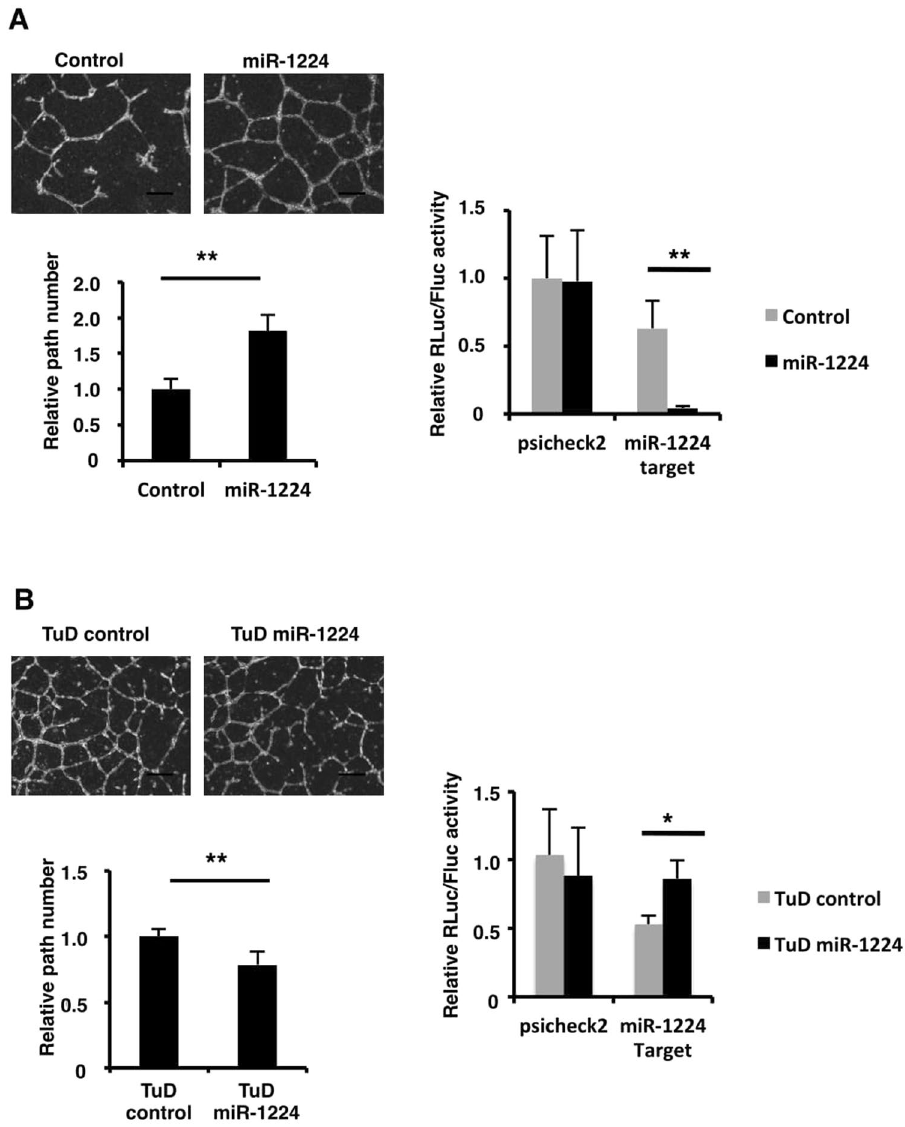
Figure 2. miR-1224 stimulated, and its inhibitor repressed, tube formation of HUVECs. ( A ) Tube formation assay of HUVECs transfected with miR-1224 mimics (left panels). Scale bars, 300 μ m. Number of branches is shown. Bars show the means ± S.D. with ** p < 0.01 (n = 4). Reporter assay in HUVECs co-transfected with miR-1224 mimics and sensor plasmids (right panel). Normalized renilla-luciferase levels (Rluc/Fluc) relative to the control plasmid with control mimics are shown. Bars show the means ± S.D. with ** p < 0.01 (n = 3). ( B ) Tube formation assay of HUVECs transfected with miR-1224 TuD (left panels). Scale bars, 300 μ m. Number of branches is shown. Bars show the means ± S.D. with ** p < 0.01 (n = 4). Reporter assay in HUVECs co- transfected with TuD and sensor plasmids (right panel). Normalized renilla-luciferase levels (Rluc/Fluc) relative to the control plasmid with the control TuD are shown. Bars show the means ± S.D. with * p < 0.05 (n =